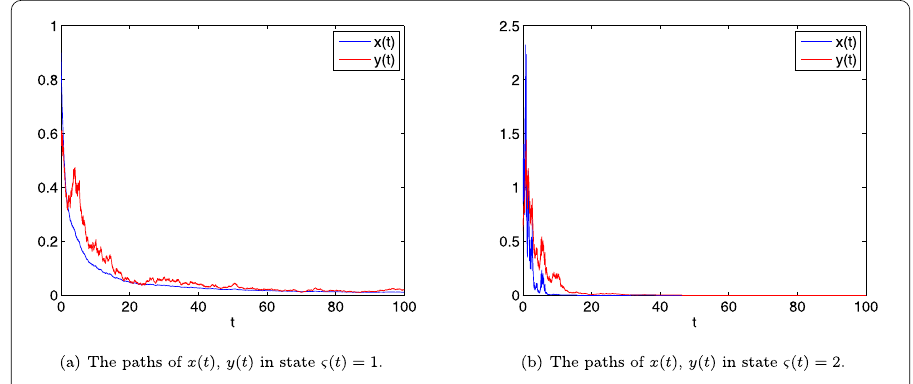
Figure 2 The time-series plots of x ( t ) and y ( t ) for model (4) with initial value ( x 0 , y 0 ) = (0.9,0.6), and other parameters are taken as in Table 2